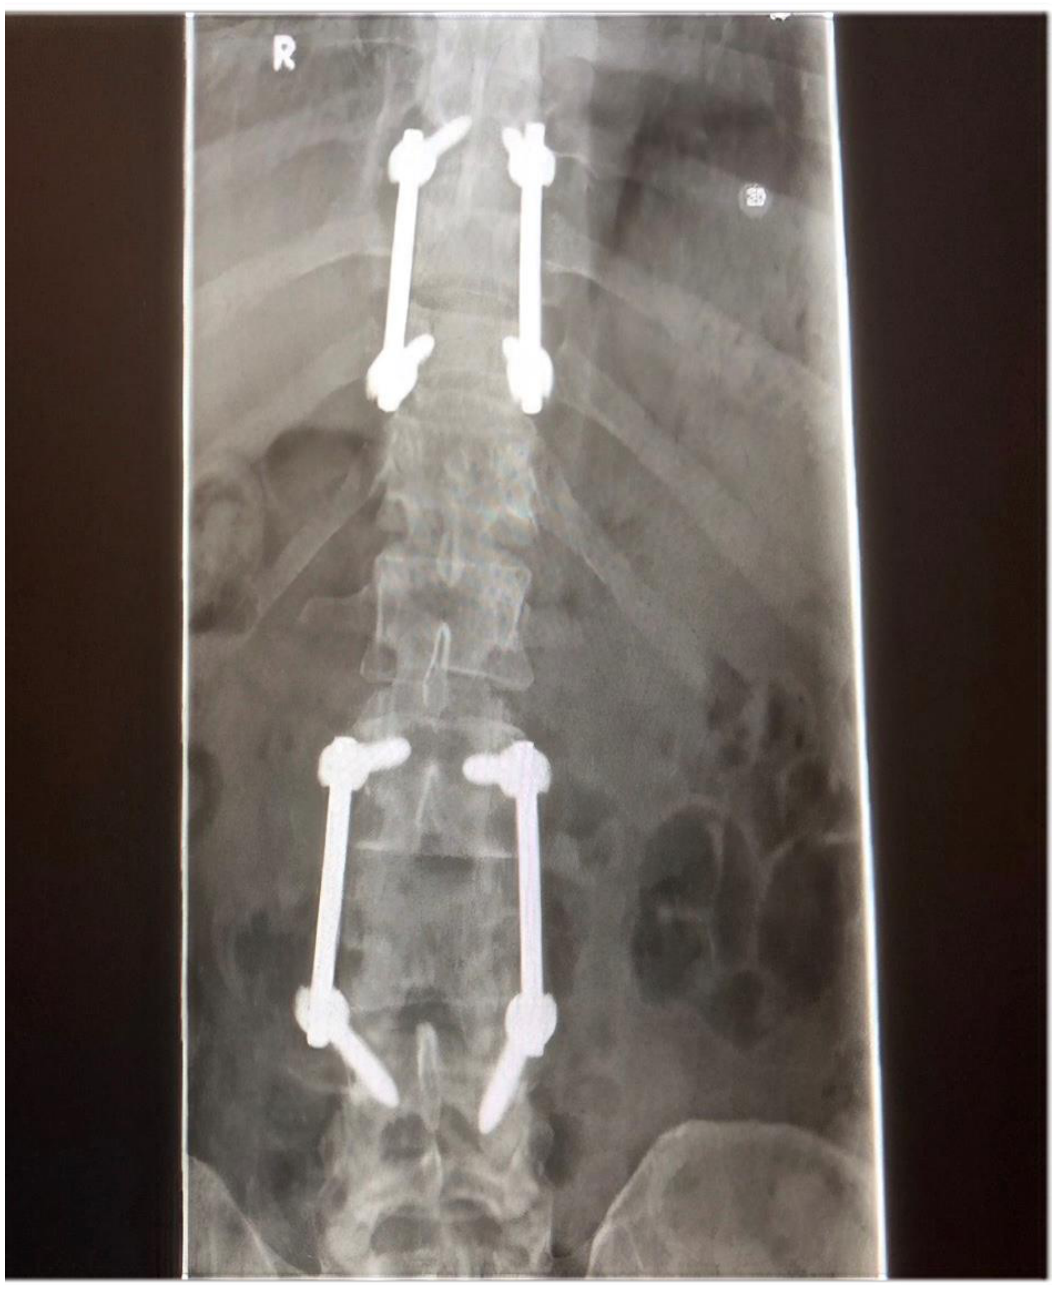
Figure 3. Post-operative x-ray demonstrating spinal stabilisation at the lumbar and thoracic areas using rods and screws.